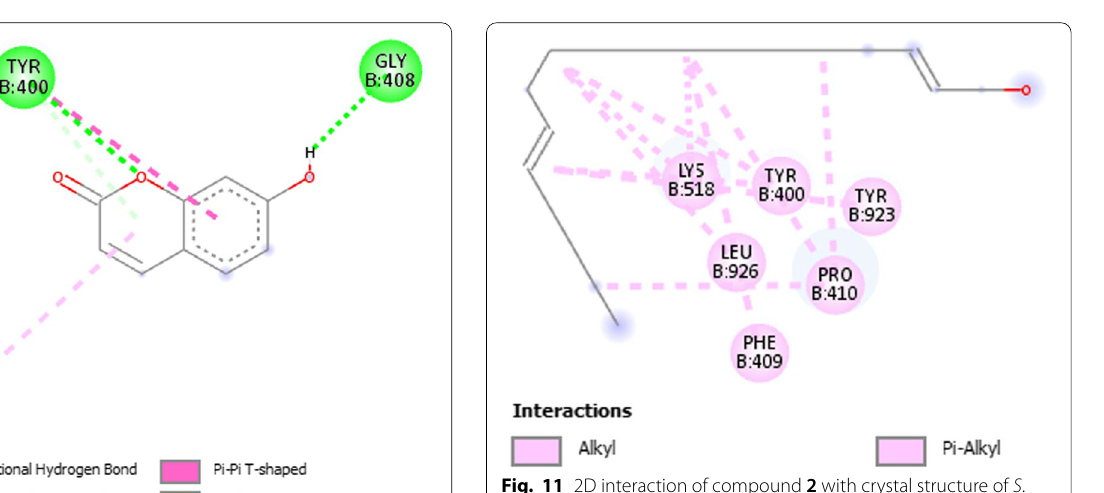
Table 3 Result of the binding scores of isolated compounds/ciprofloxacin with active site of receptor (PDB: 3HO8) Ligands Binding Score (Kcal/mol) Protein interaction Types of interaction Bond